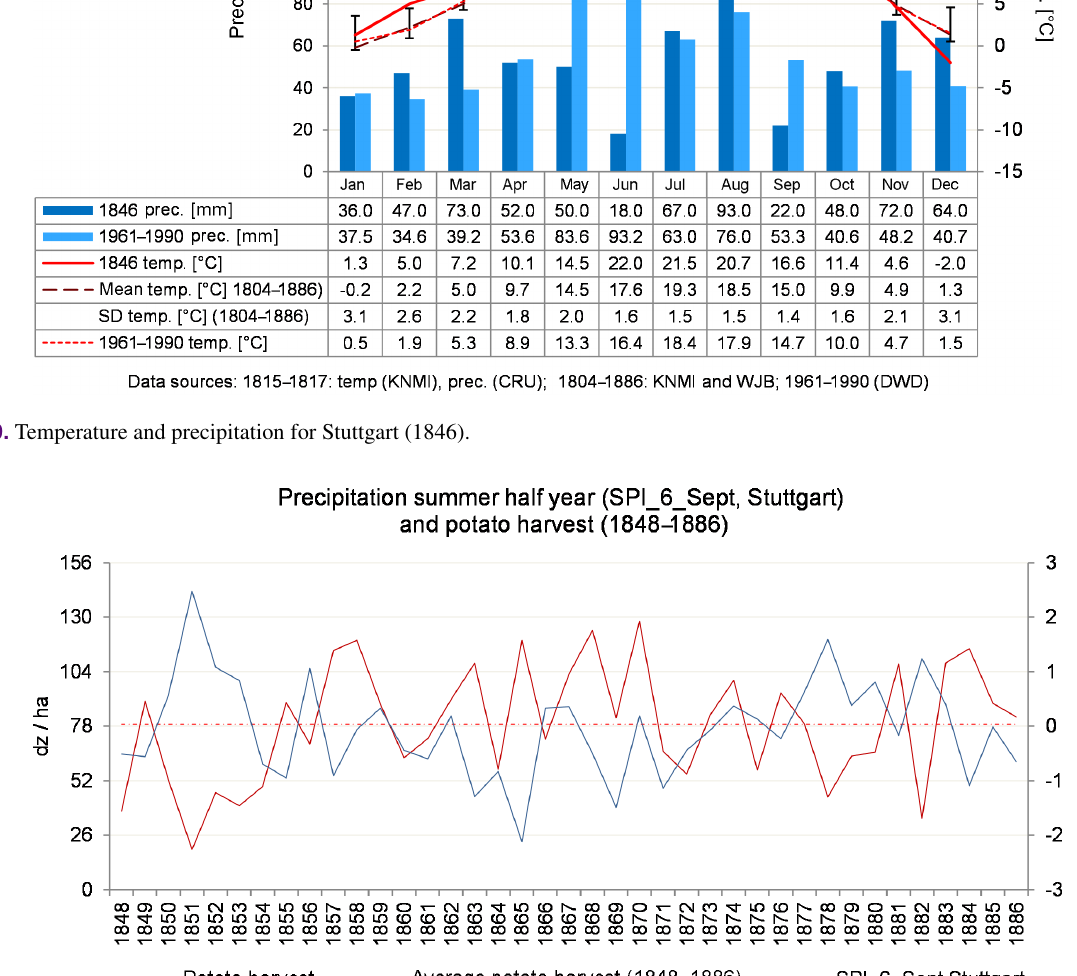
60 606 people from Baden left their countries. The main peak was reached in 1853/54, when 21 320 (Württemberg) and 21 561 people (Baden) emigrated. No other period within the 19th century reached this dimension (see Fig.